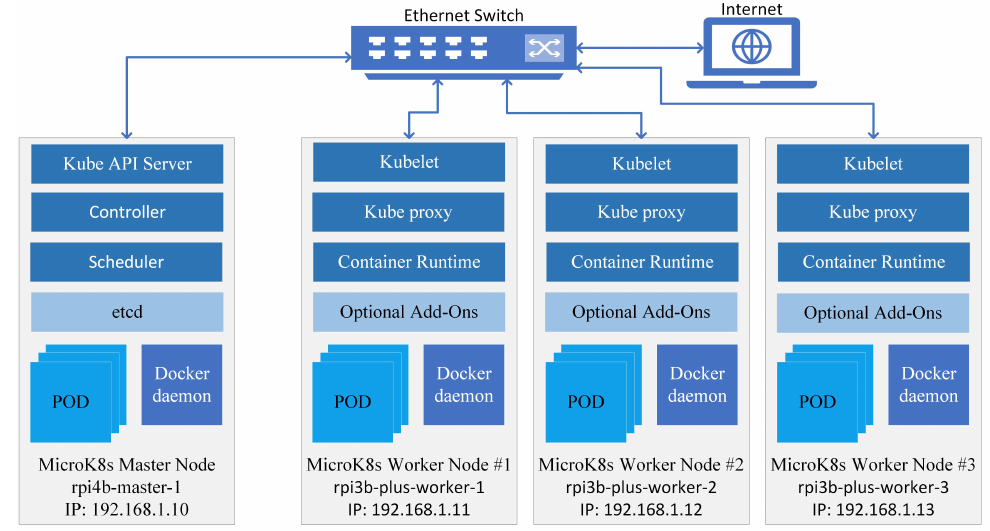
Figure 2. The MicroK8s architecture for the distributed system in this study